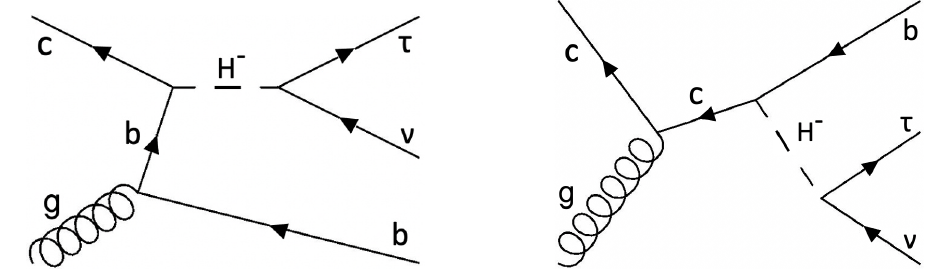
Figure 1 . Representative Feynman diagrams for the bτν signal from H −